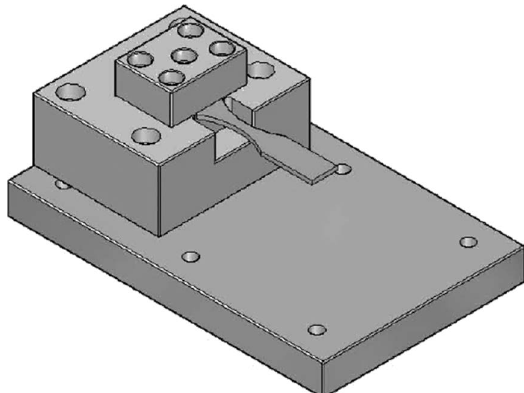
Figure 2. Device used in the bending fatigue